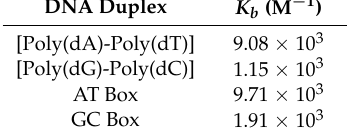
Table 2. K b values for compound 4a with various DNA sequences.